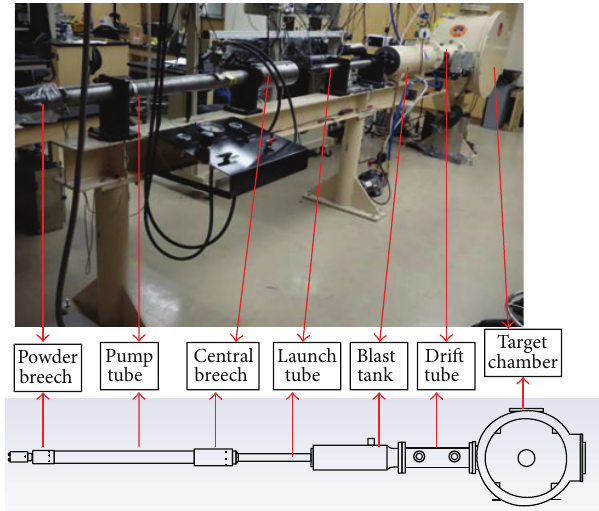
Figure 1: Two-stage light-gas gun.